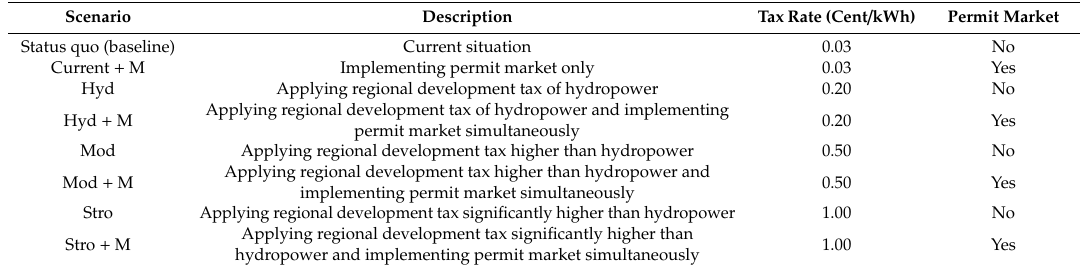
Table 2. Scenarios for combined air quality improvement policies.